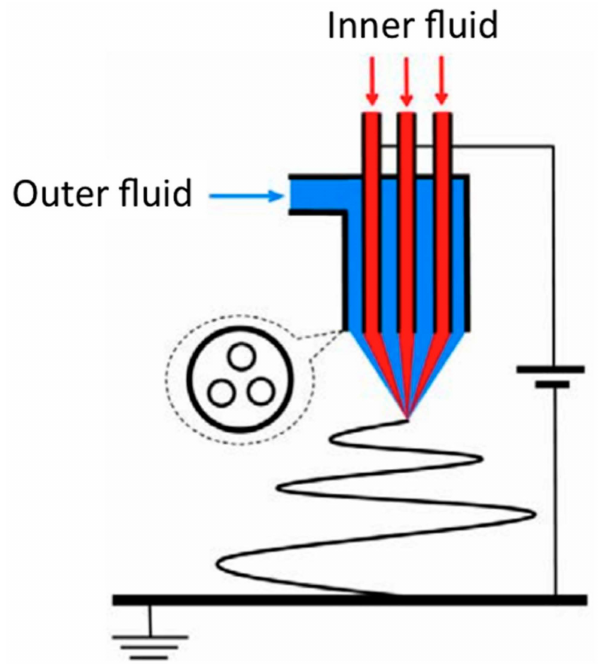
Figure 9. A schematic illustration of an example of a multiaxial spinneret system. Reprinted with permission from [45], IntechOpen,